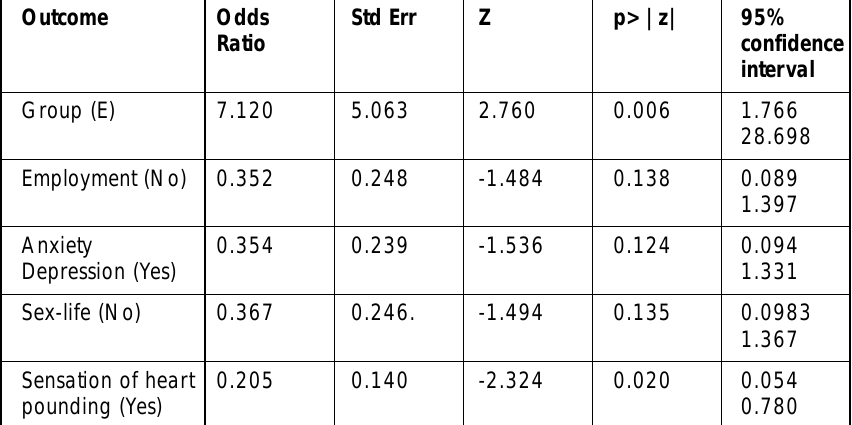
Table 3: Adjusted odds ratios and 95% confidence intervals Outcome Odds Std